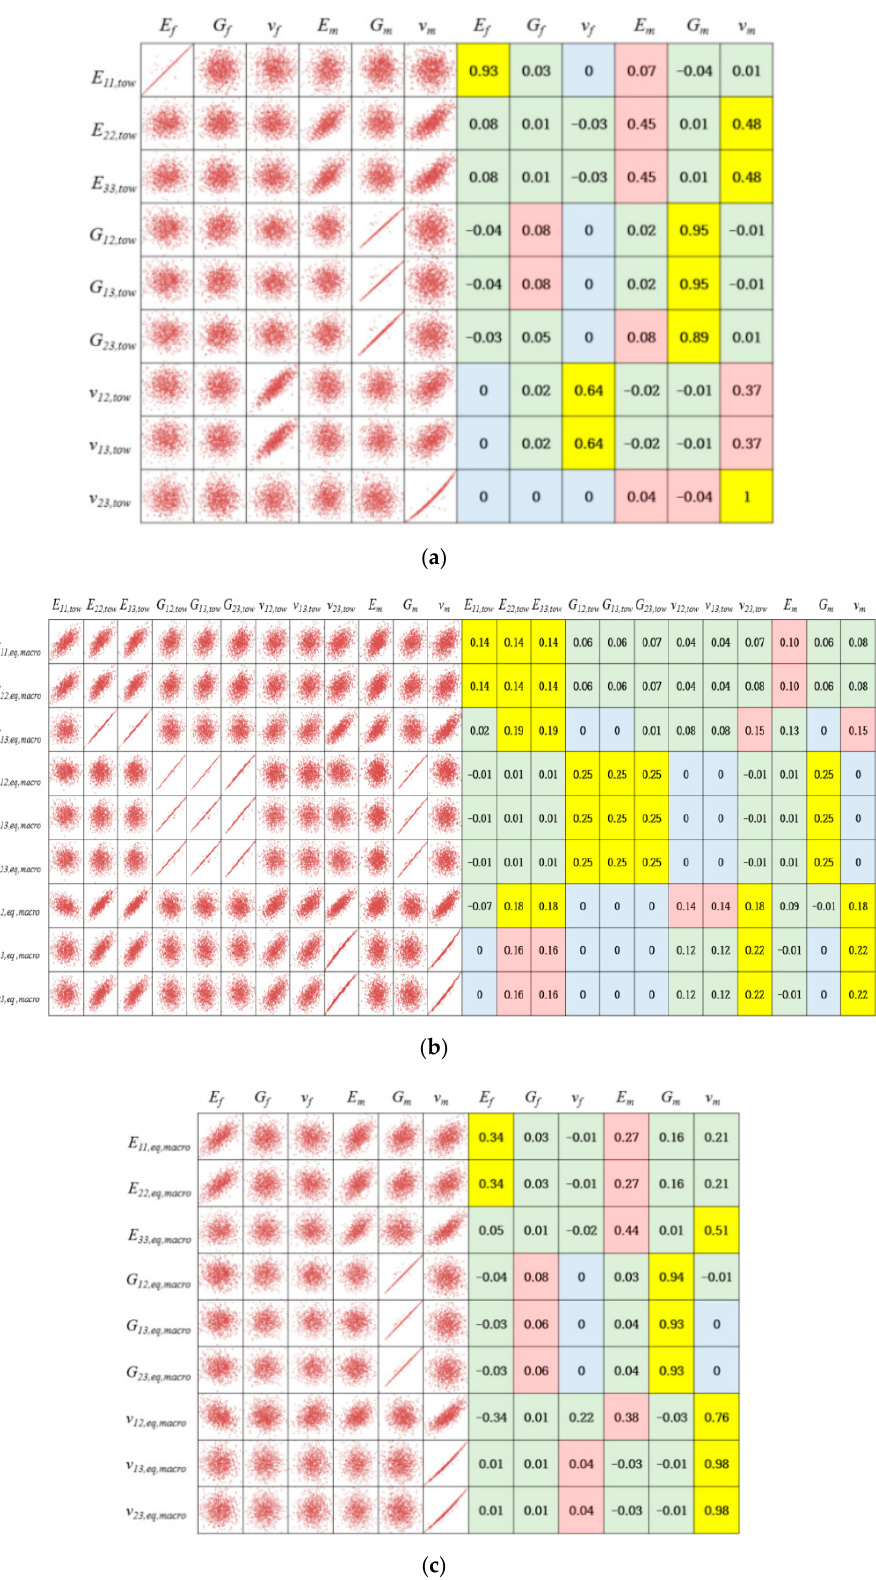
Figure 9. Linear correlation results; ( a ) Comparison of the micro-level and mechanical properties of the fiber and matrix; ( b ) Comparison of the macro- and micro-levels; ( c ) Comparison of the macro-level and mechanical properties of the fiber and